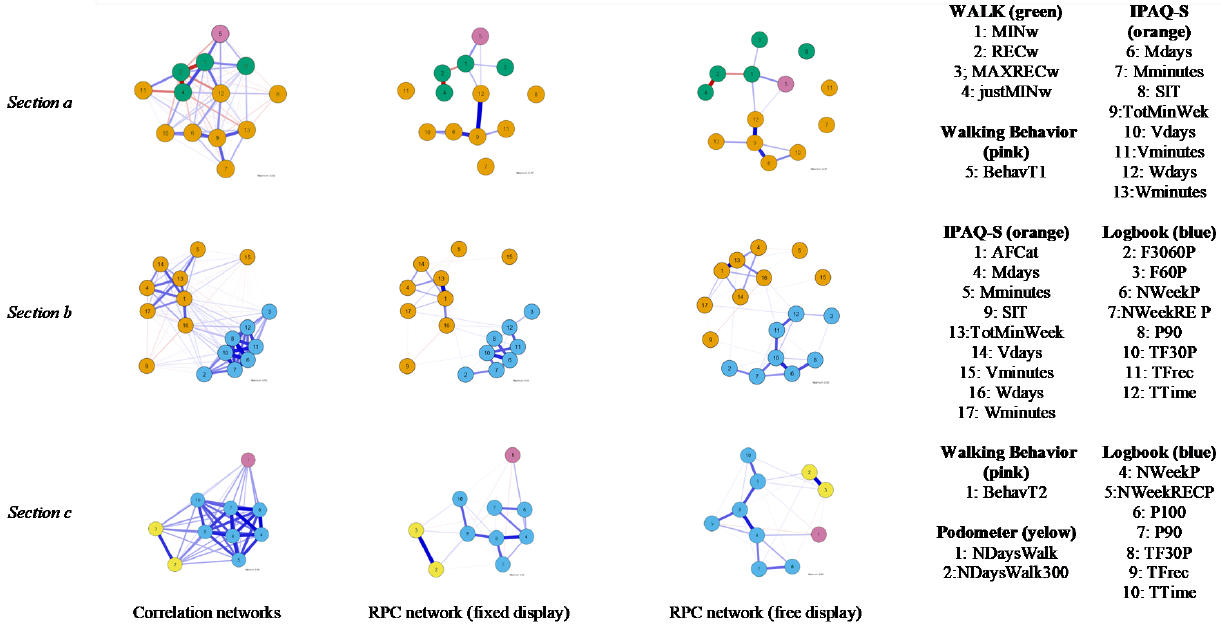
Figure 2. Regularized partial correlation networks for the WALK, Walking Behavior, IPAQ-S, logbook and pedometer measures.